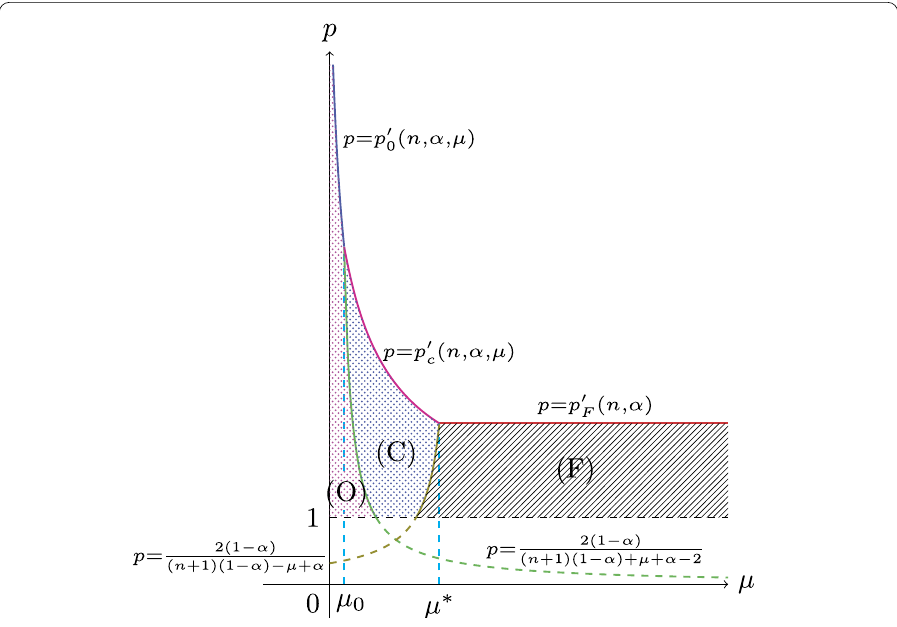
Figure 5 Range of blow-up conditions in case n = 3 and α =